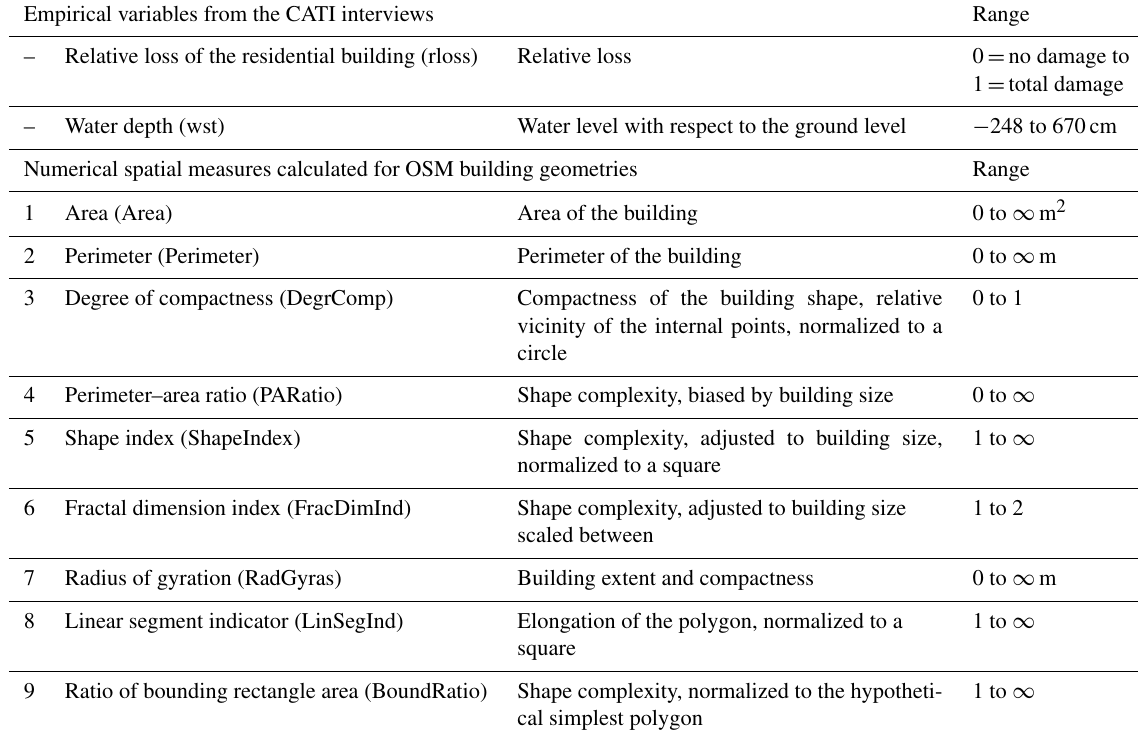
Table 2. Variables of the amended OSM data set for each building object Empirical variables from the CATI interviews Range Relative loss 0 = no damage to 1 = total damage Water level with respect to the ground level − 248 to 670cm Numerical spatial measures calculated for OSM building geometries Range Area of the building 0 to ∞ m 2